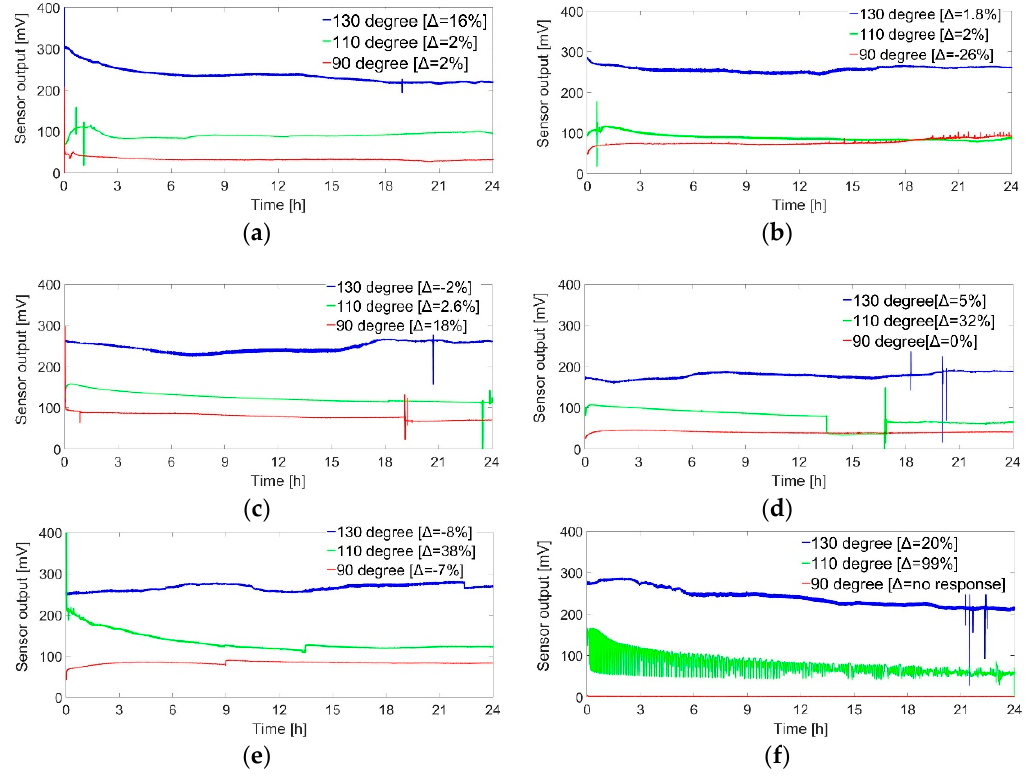
Figure 13. Sensor output for 72 h test (combination of three 24 h test at 130 °C, 110 °C and 90 °C operating temperature) at 1.5% continuous hydrogen flow for ( a ) Pt-PDA; ( b ) Pt-DATER; ( c ) Pt-BEN; ( d ) Pt-DAN;